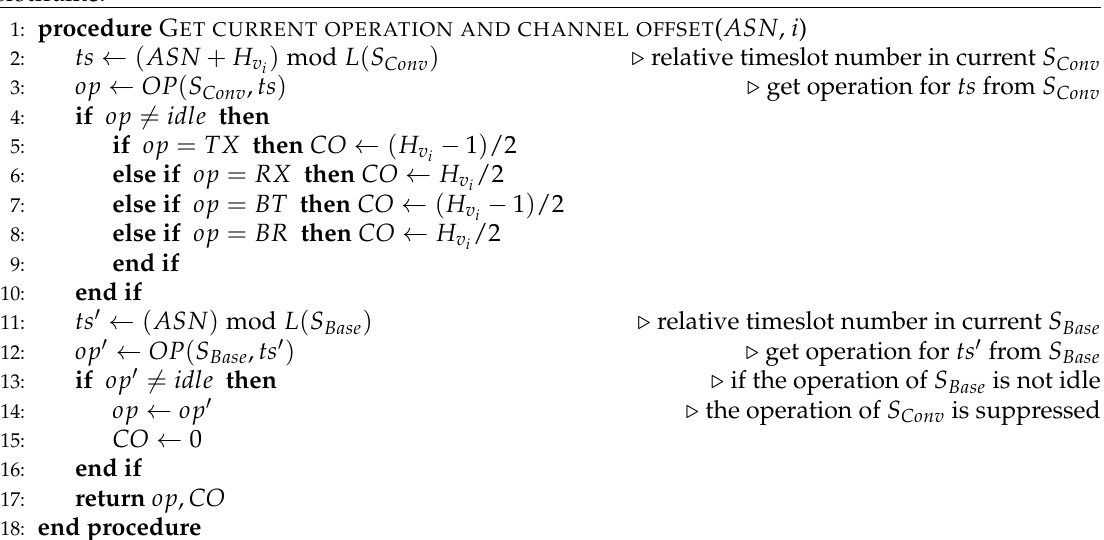
Algorithm 2 Decide current timeslot operation and channel offset selection of the convergecast